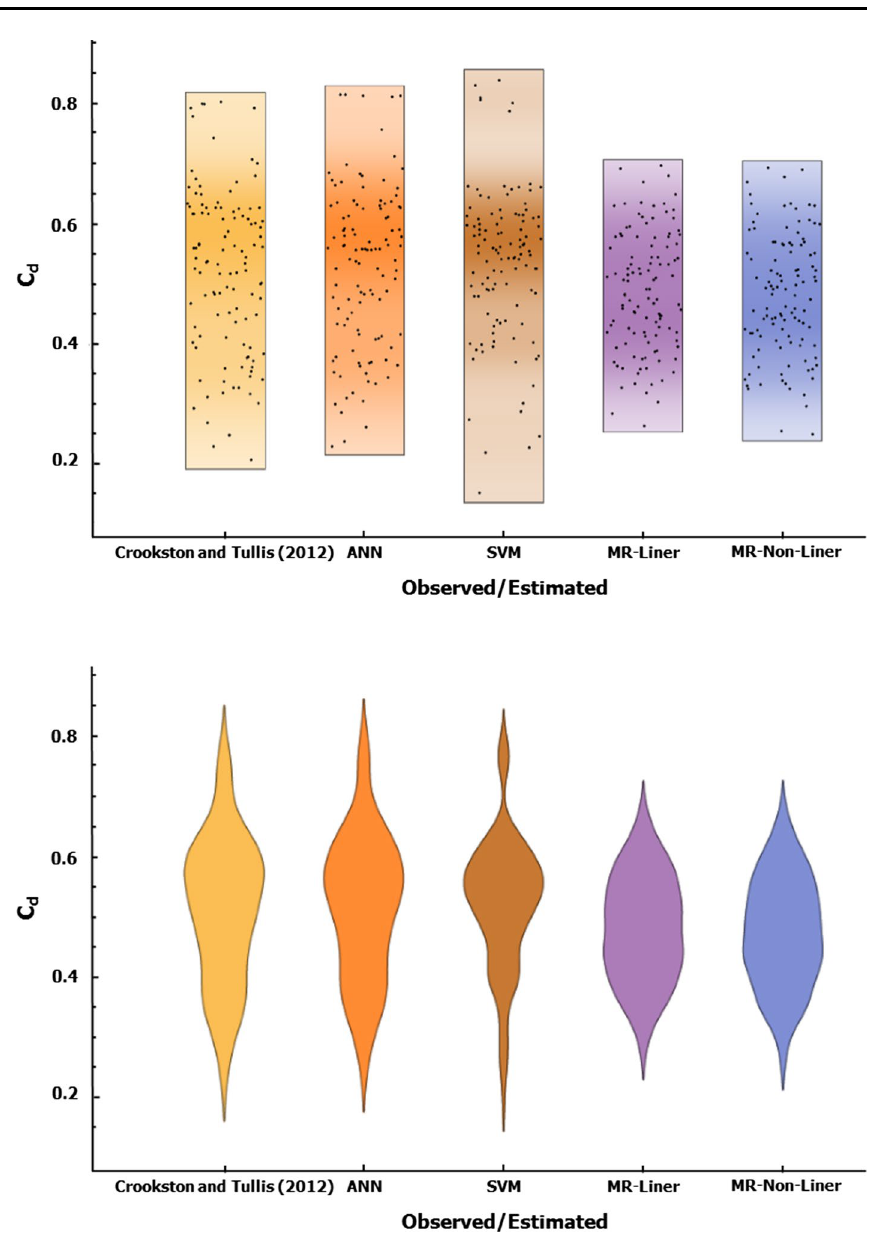
Fig. 7 Density plot for data in the test period for observational and estimated data